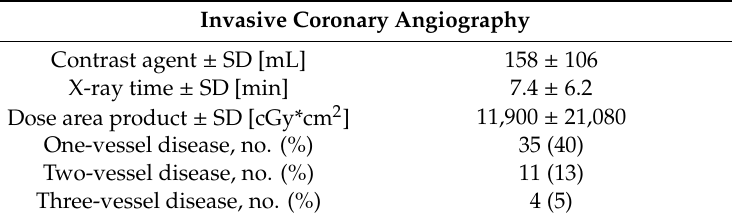
Table 5. Findings of ICA ( n =